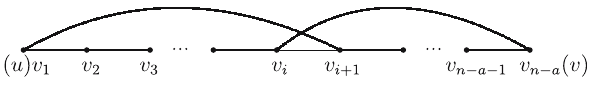
Figure 2: A nonhamiltonian